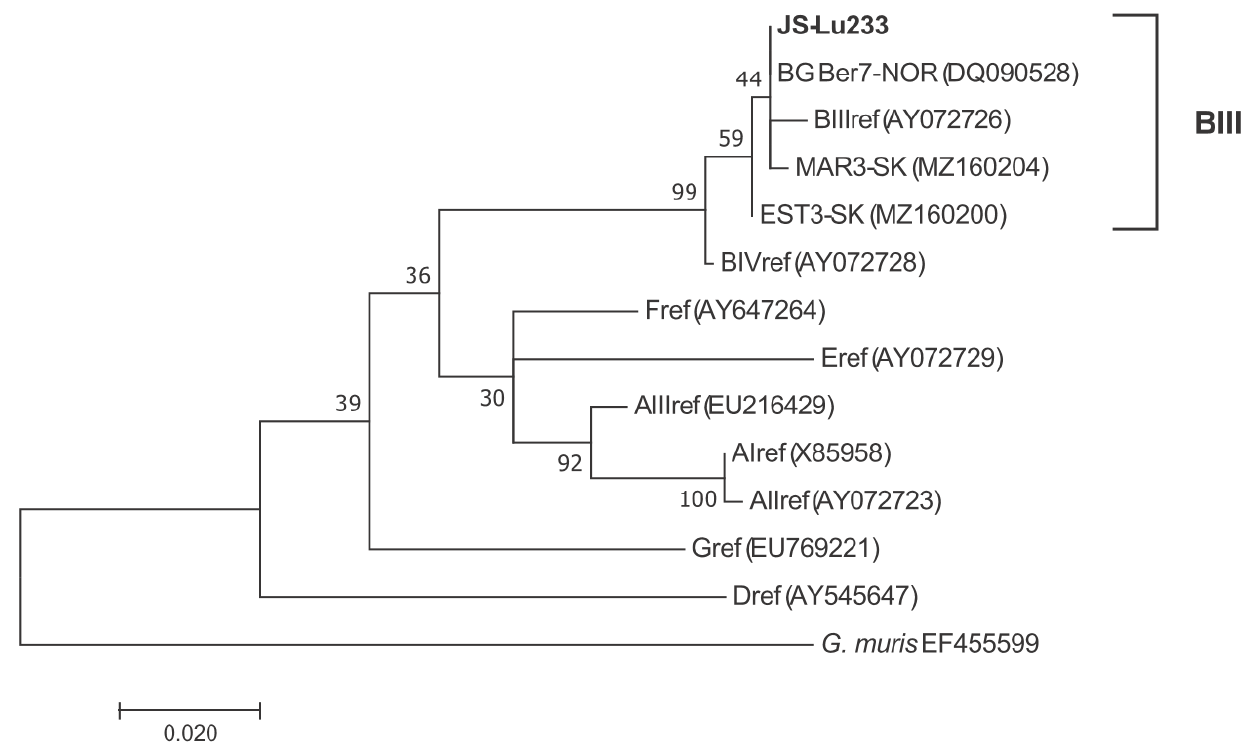
Figure 2. Maximum-likelihood phylogram generated from a partial bg gene (485 bp) showing relationships between the examined Slovak isolates of Giardia duodenalis and GenBank-retrieved related sequences. The G. muris sequences from the mouse (ref. No. EF455599) were used as an outgroup. The scale bar refers to a phylogenetic distance of 0.02 nucleotide substitutions per site. Numbers next to the branches indicate the bootstrap value calculated from 1000 pseudoreplicates. Geographical origin of the examined isolate in Slovakia: Lu Luník IX (Košice district, south-eastern Slovakia). Isolates MAR3-SK and EST3-SK correspond to previously recorded profiles in Slovak humans for assemblage A using the bg gene.